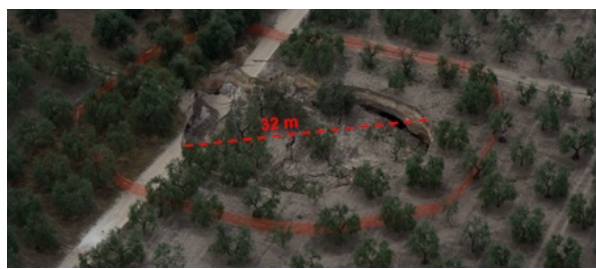
Figure 5. Aerial view of the sinkhole that occurred in the Barletta